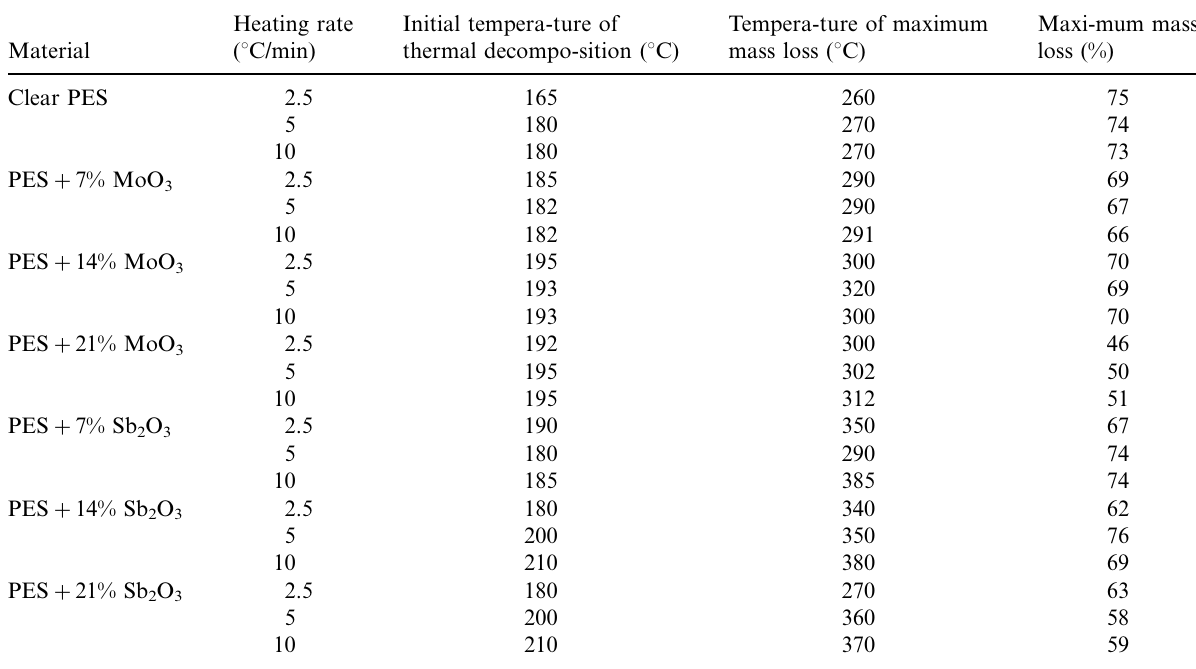
Table 1. Decomposition temperatures and mass loss of the studied polyester materials Heating Material